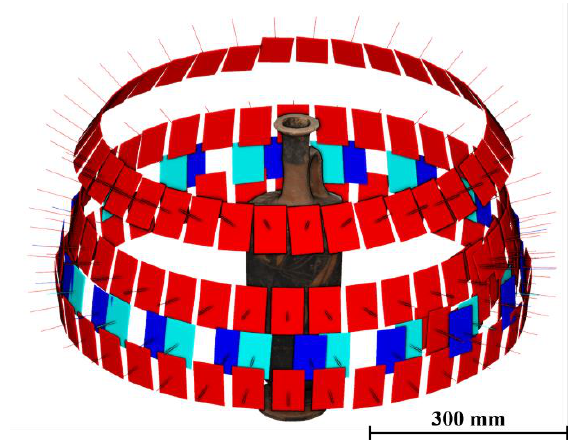
Figure 3. Computed camera networks for the various image acquisitions: VIS imagery – photogrammetry (red), UVL @ 254 nm (blue) and UVL @ 366 nm